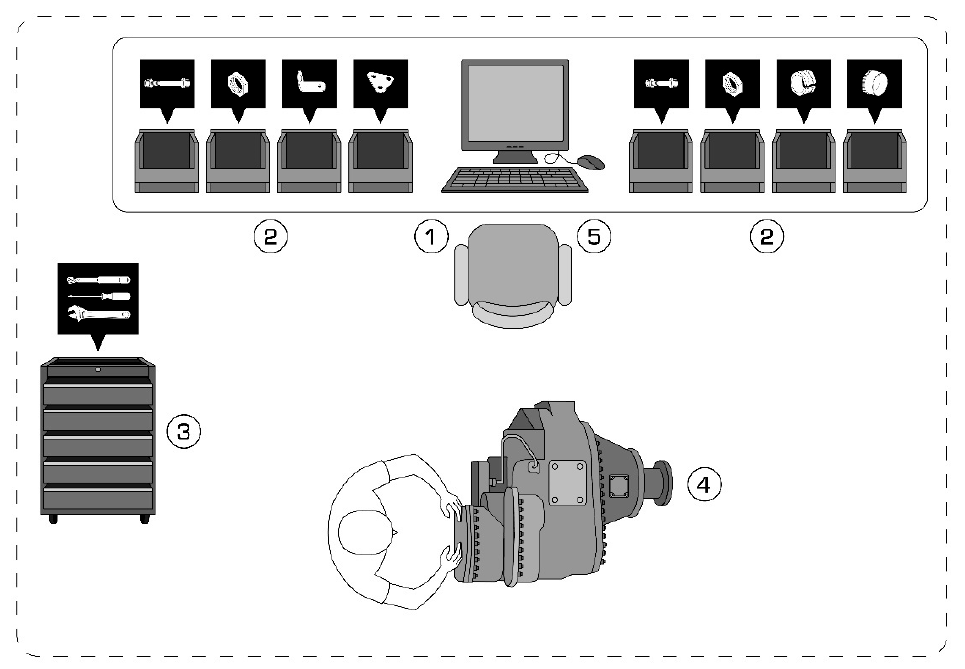
Figure 3. Workstation’s layout (not to scale) and general workflow: (1) read work instruction on the PC, (2) pick the parts from bins, (3) pick tools from the tool cabinet, (4) execute assembly operations and (5) close work instructions on the PC .